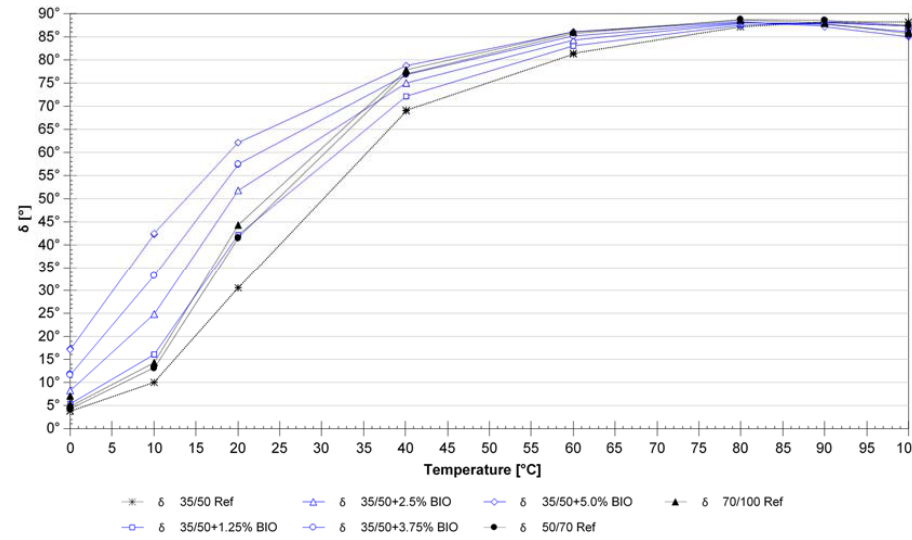
Figure 3. Phase angle | δ | for reference bitumens and 35/50 bitumen modified with bio ‐ agent.